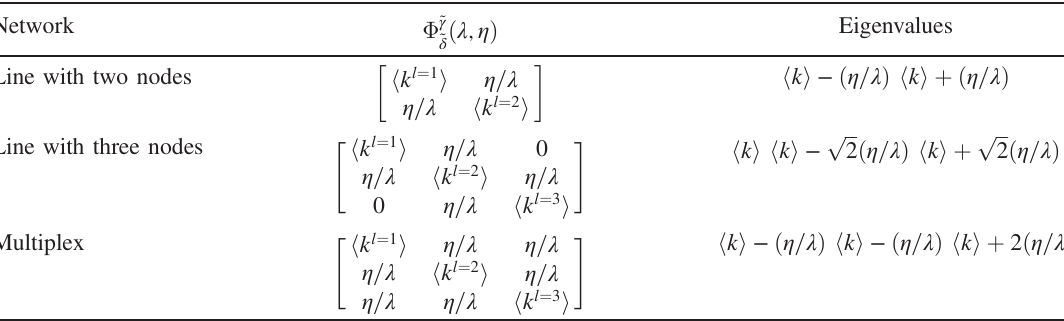
ð λ ; η Þ . The eigenvalues assumes that the δ